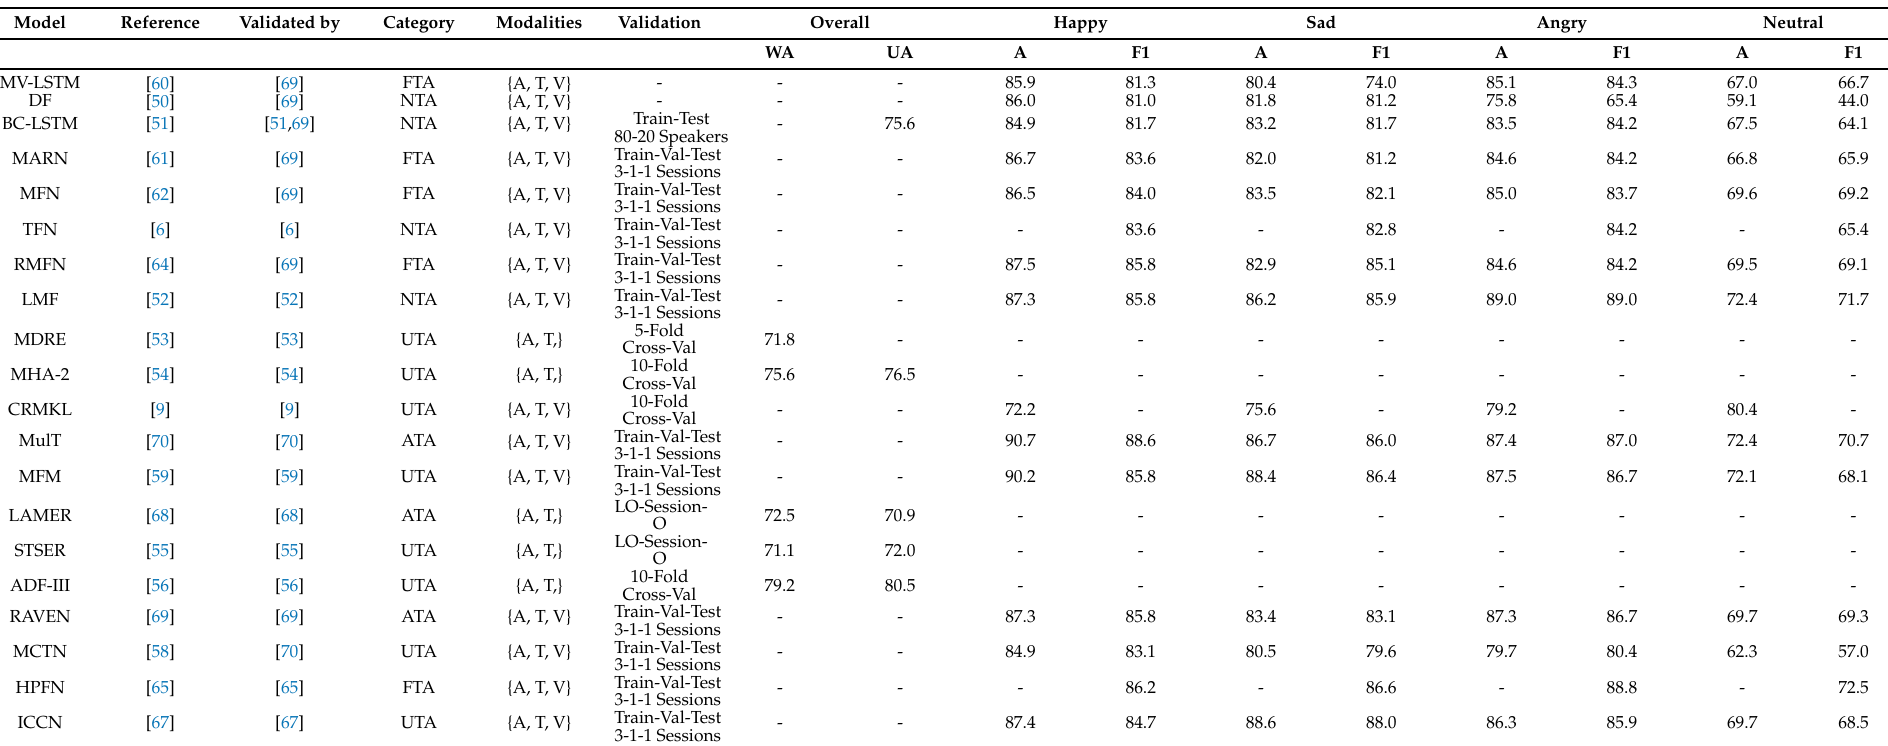
Table 2. Multimodal emotion recognition evaluation results with rounding to one decimal place. The works in which a specific multimodal architecture was validated are indicated under the “Validated by” column, while the type of validation is marked in the “Validation”